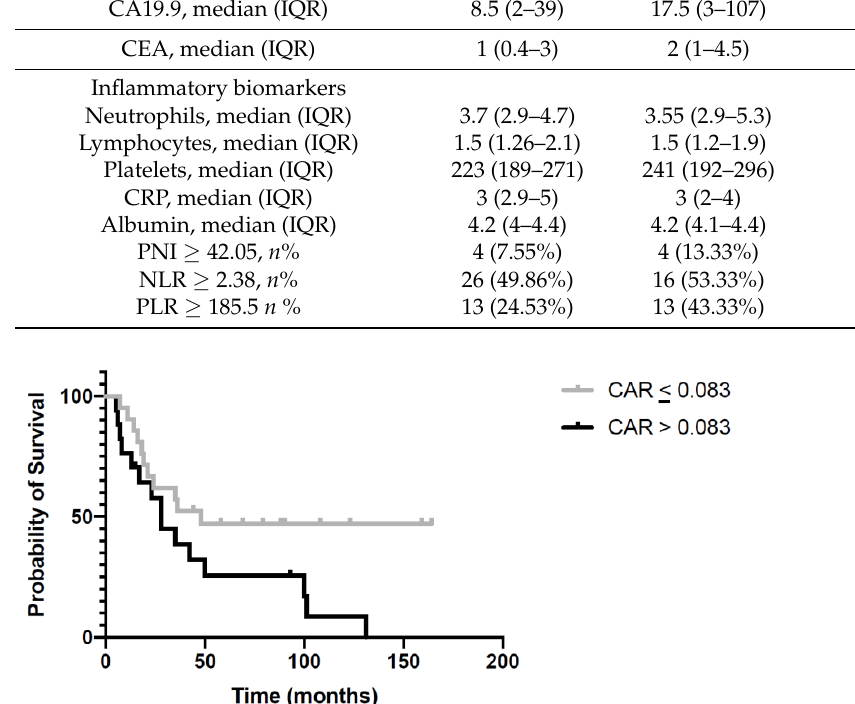
Figure 3. Kaplan–Meier curve for overall survival estimated for patients with C-reactive protein to albumin ratio (CAR) values > 0.083 or ≤ 0.083. CAR > 0.083 was significantly associated with worse survival ( p = 0.004).